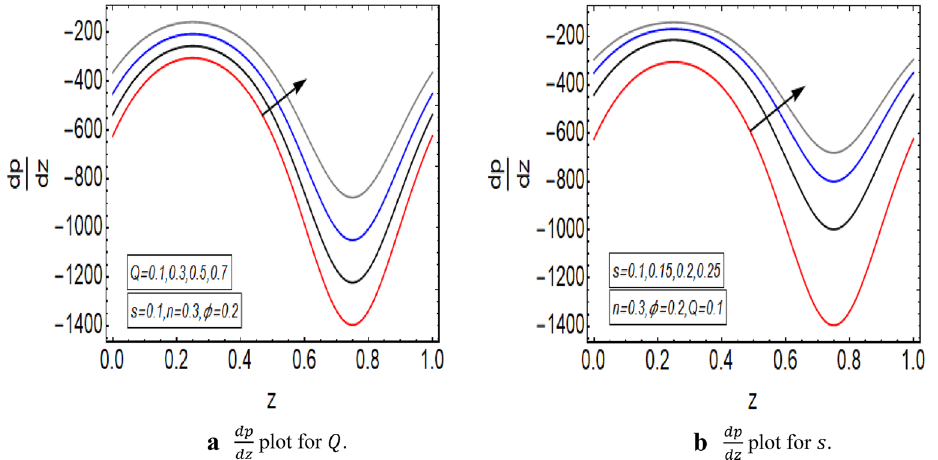
Figure 4. ( a ) dp dz plot for Q . ( b ) dp dz plot for s .